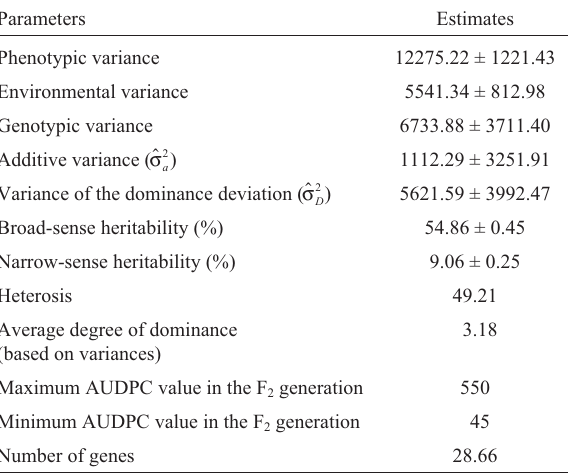
Table 4 - Estimates of the genetic parameters of late blight caused by Phy- tophthora infestans in the parental (P 1 , P 2 ), filial (F 1 , F 2 ) and backcross (BC 1 , BC 2 ) generations of the tomato cross ‘Santa Clara’ x BGH 6902. The maximum and minimum area under the disease progress